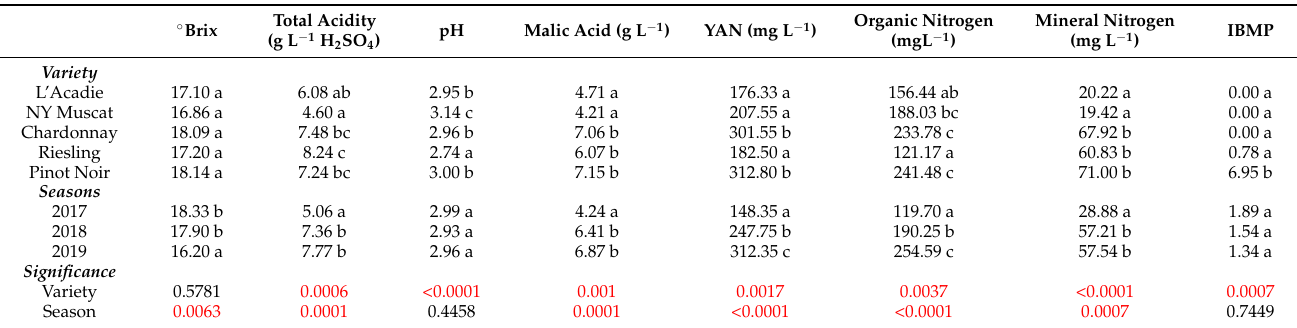
Table 6. Effect of variety on must physico-chemical parameters of grapevines growing under cold climate conditions over three consecutive